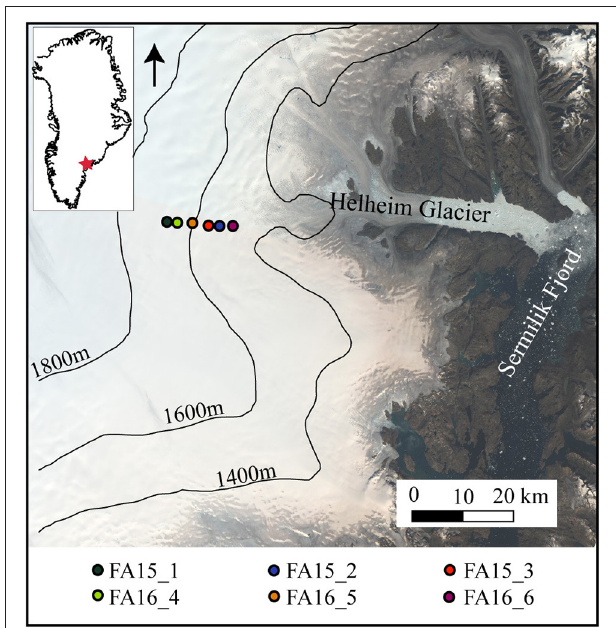
FIGURE 1 | Site map. Landsat 8 composite image (August 21, 2014) showing sites in southeast Greenland where slug tests and aquifer tests were conducted in April, July, and August 2015 and July and August, 2016. Elevation contours from Cryosat-2 DEM (Helm et al.,